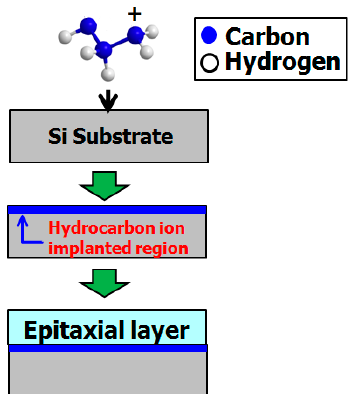
Figure 2. Production of hydrocarbon–molecular–ion–implanted epitaxial silicon wafers. Modified from Kurita et al. [29], Copyright (2016) The Japan Society of Applied Physics.